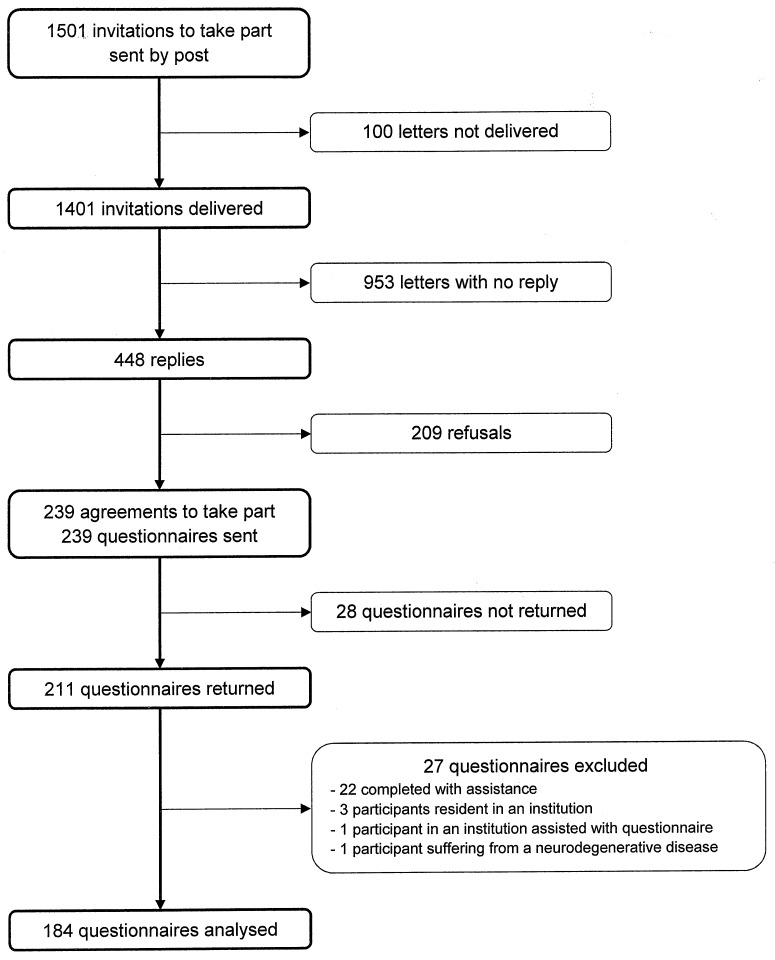
Organization chart of participation in the study.